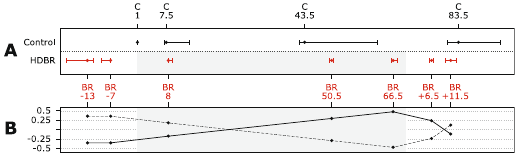
Figure 1. Testing Timeline and Analysis Contrast. ( A ) Testing Timeline: Median (with interquartile range) days at which data was collected for the control (n = 12) and head down-tilt bed rest (HDBR) subjects (n = 16). The gray rectangle in the figures indicates time in HDBR. BR − 13 = 13 days pre-HDBR. BR + 6.5 = 6.5 days post- HDBR. ( B ) HDBR related increases and decreases in FW/FA followed by recovery were modeled separately using the two depicted a priori defined contrasts. Y-axes indicate the contrast values used in our analyses that model accumulating effects of HDBR and recovery post-HDBR. (HD)BR = head down-tilt bed rest; solid line = contrast assuming stable outcome measures pre-HDBR, linear increase over HDBR, and partial recovery post-HDBR; dashed line = contrast assuming stable outcome measures pre-HDBR, linear decrease over HDBR, and partial recovery